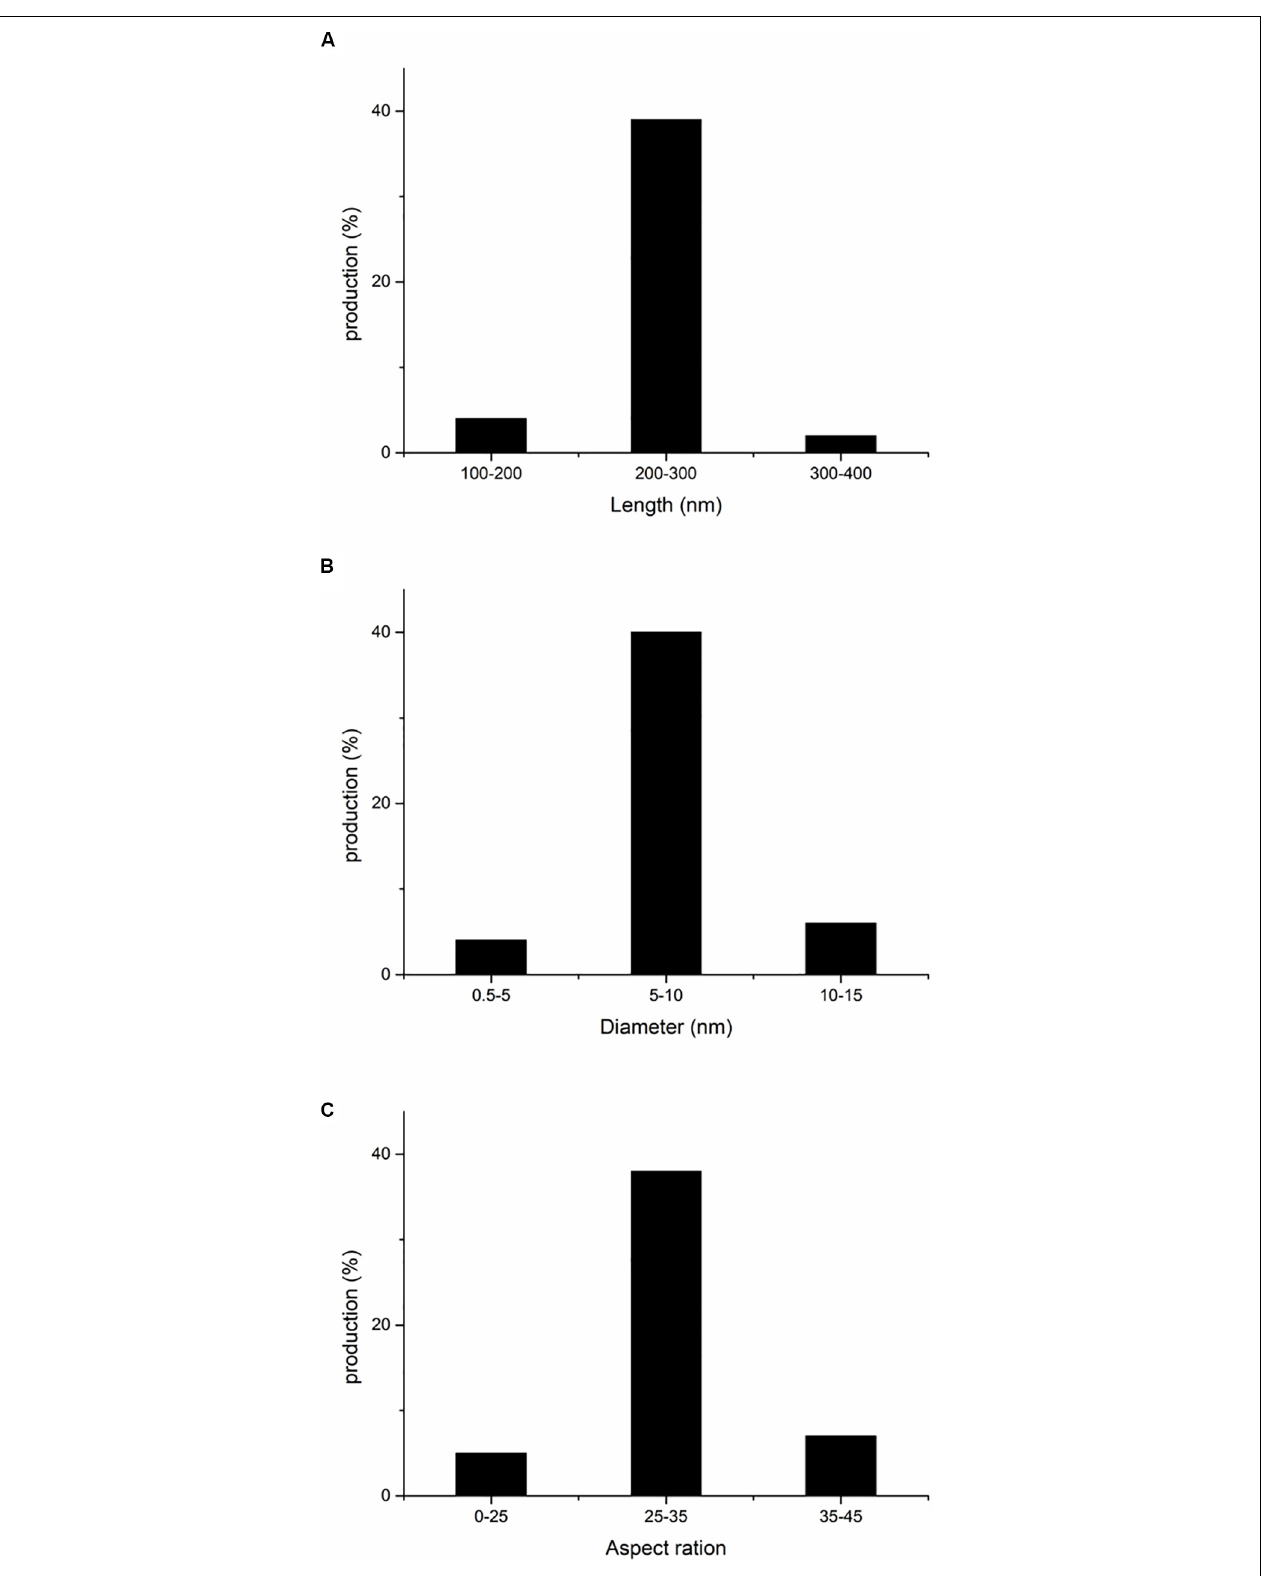
FIGURE 3 | Distributions of morphological data of ASCNC. (A) Length; (B) diameter; (C) aspect ratio.